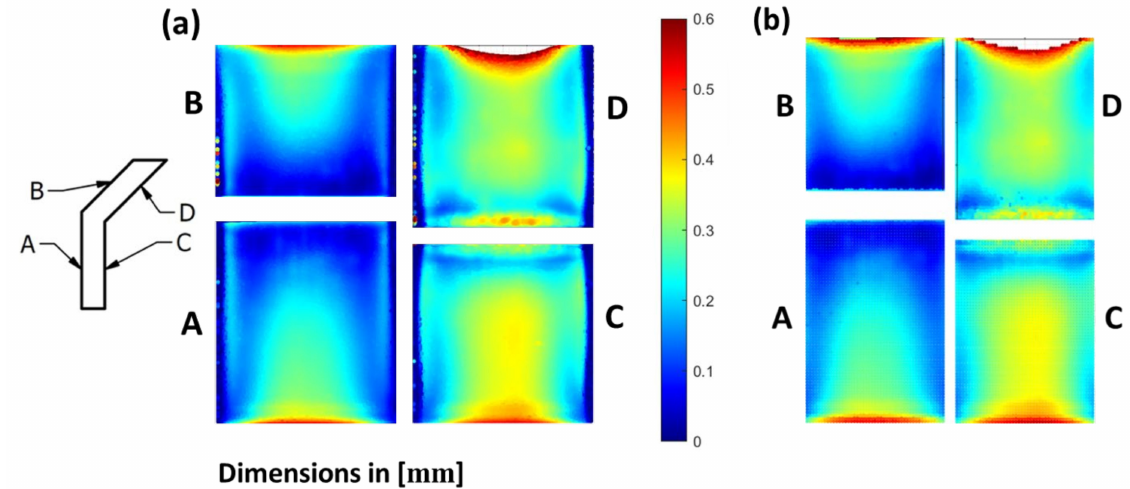
Figure A1. MATLAB: V-Shape Pre-Polished MR t : ( a ) 3D microscope point cloud (6 285 414 points); ( b ) CFD point cloud assignment (11 616